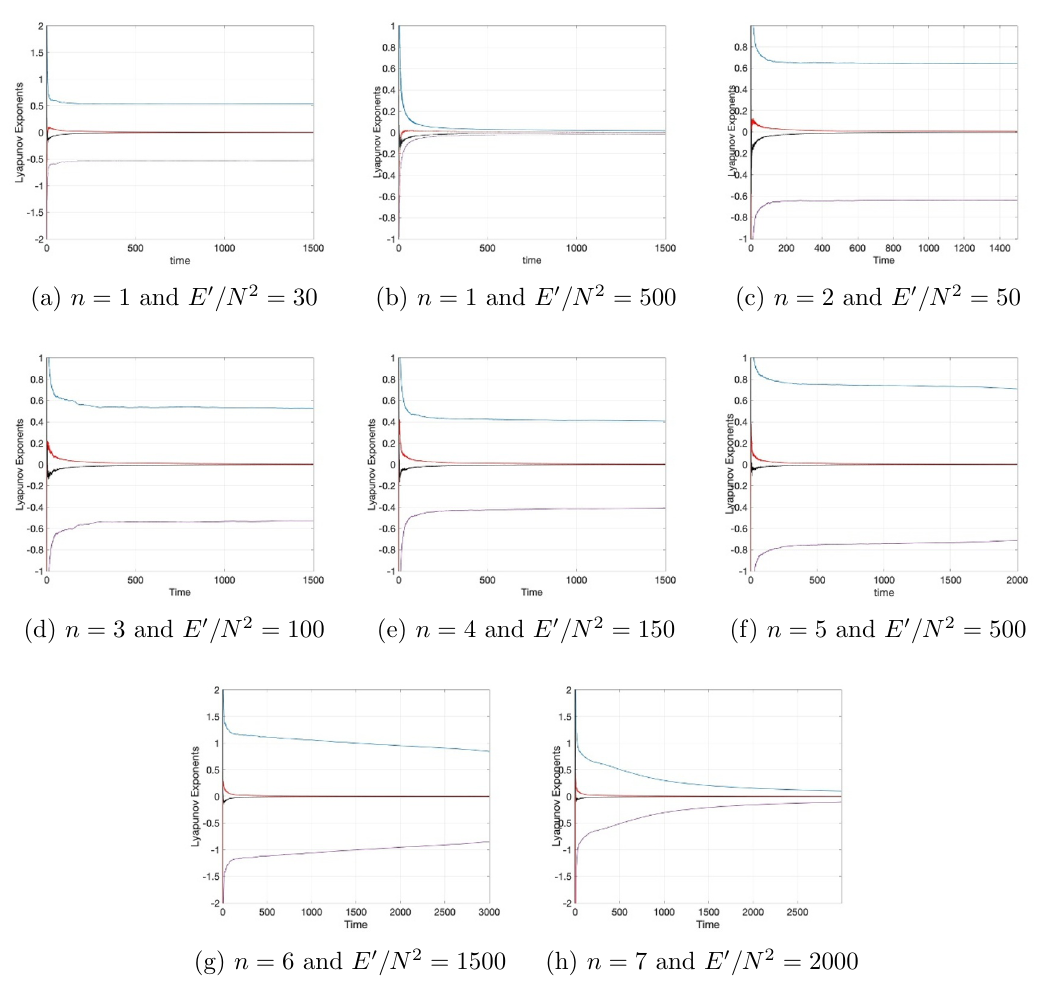
Figure 1. Time Series for Lyapunov